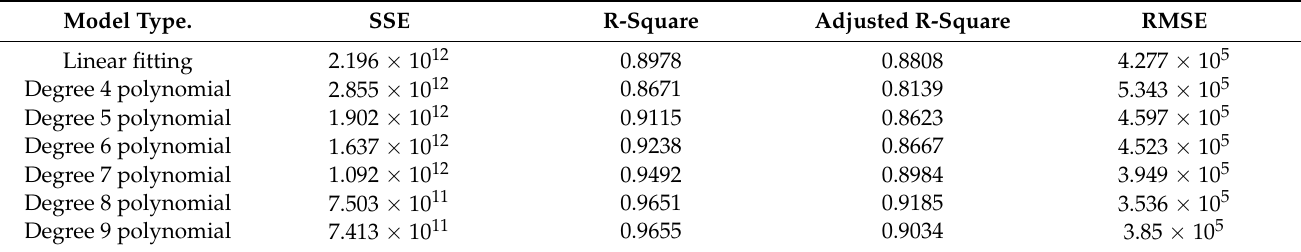
Table 1. The overview of tested models with corresponding